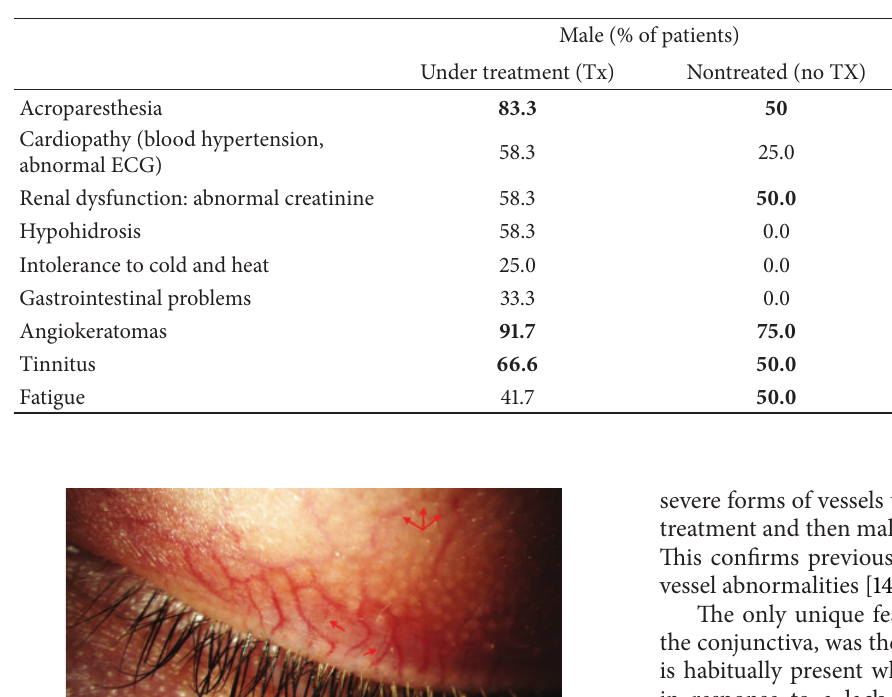
Table 4: Reported symptoms of Fabry patients.